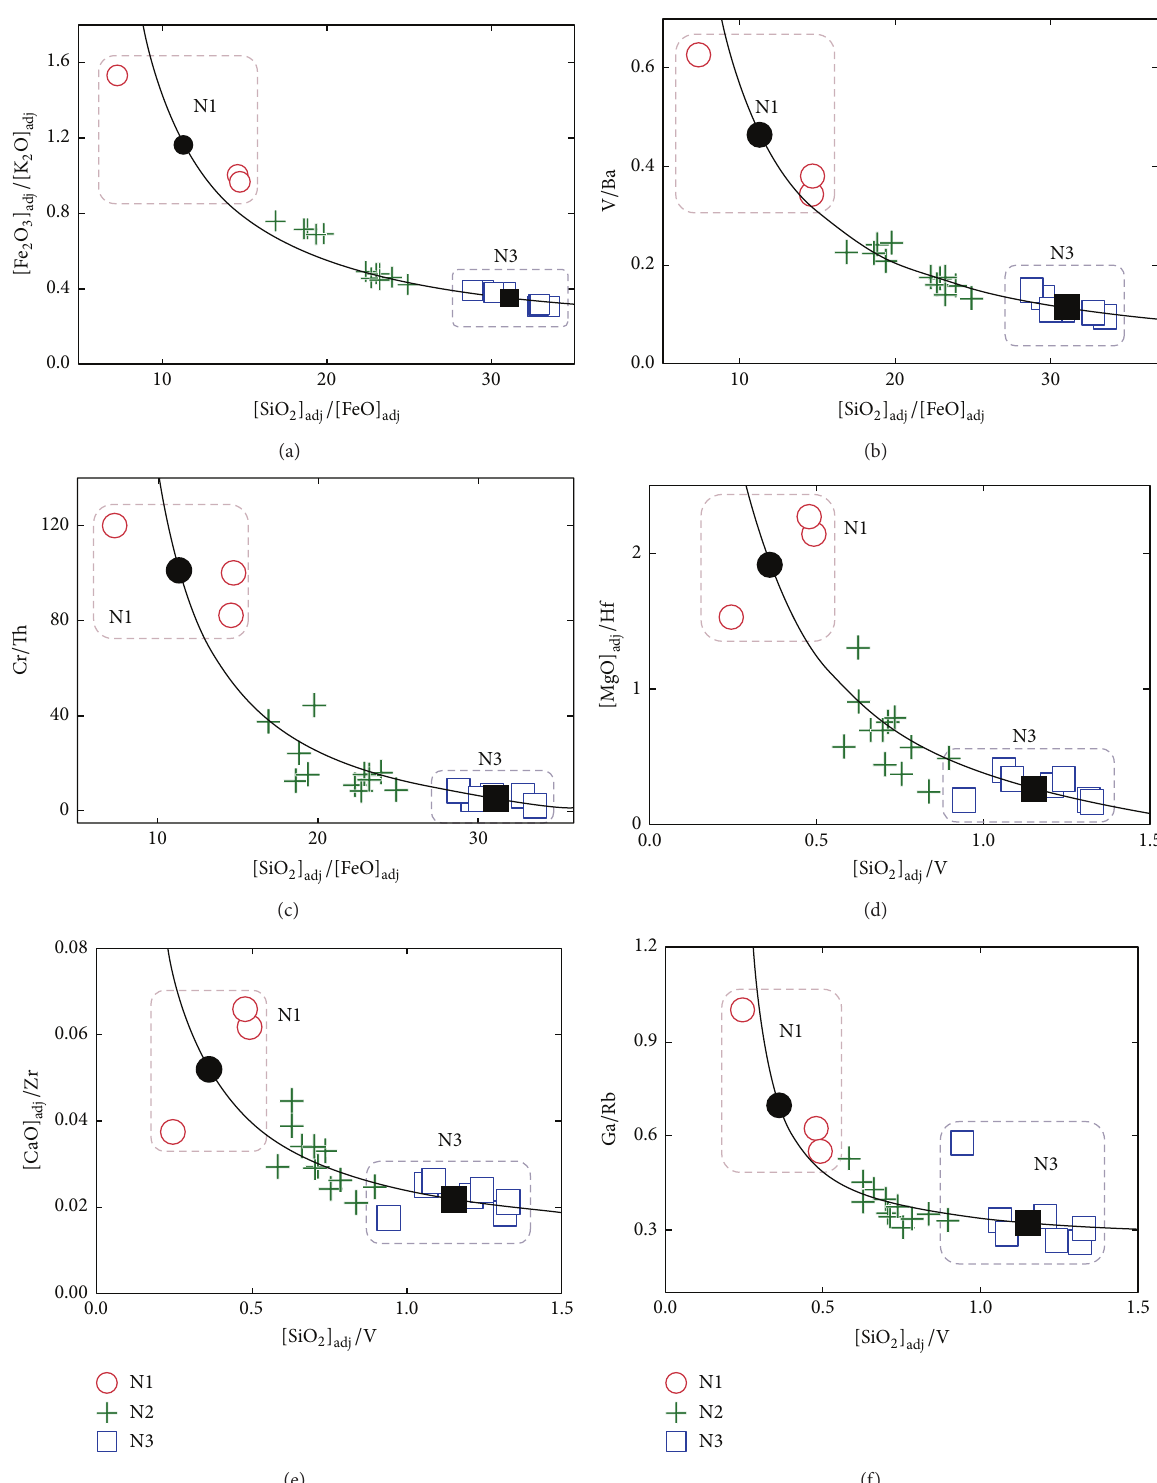
Figure 15: Geochemical ratio-ratio diagrams of the Sierra de las Cruces northern sector that include hyperbolic mixing models (black solid line) between average intermediate N1 lavas (black filled circle, 𝐼 ] /[ K ] − [ SiO ] /[ FeO ] [ Fe ; (b) V/Ba −[ SiO 2 ] 2 O 3 2 O 2 adj adj adj adj / Zr −[ SiO ] / V; (f) Ga/Rb −[ SiO ] [ CaO ] /V. Hyperbolic mixing equations, generated following the mass-balance approach by Zou [33], 2 2 adj adj adj are reported in Table